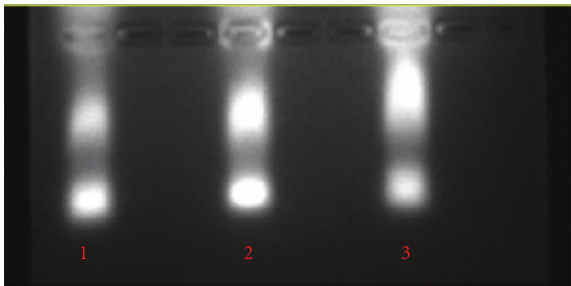
Figure 7: Agarose gel shift of RNA (lane 1), RNA + GNP (lane 2), or RNA + protamine + GNP (lane